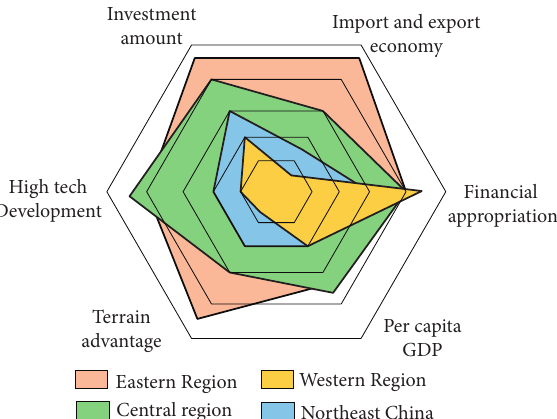
Figure 7: Influence chart of reflecting factors on the change rate of regional economic development index in China.